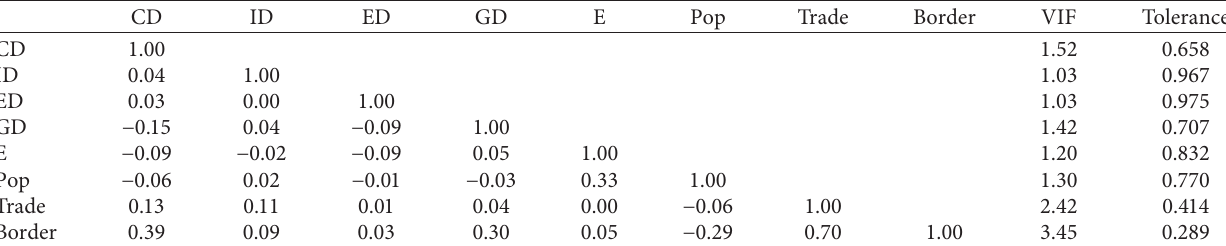
Table 2: Summary of the descriptive statistics and correlation of the variables.